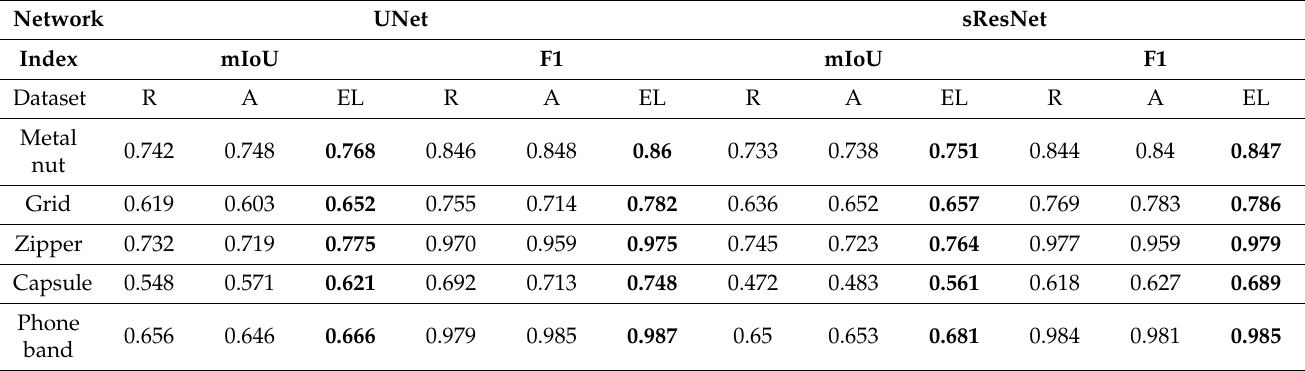
Table 4. Comparison of the mean test results for the three training sets. Bold fonts indicate the optimal IoU and F1 among the three results. R and A denote RAW and AUG,